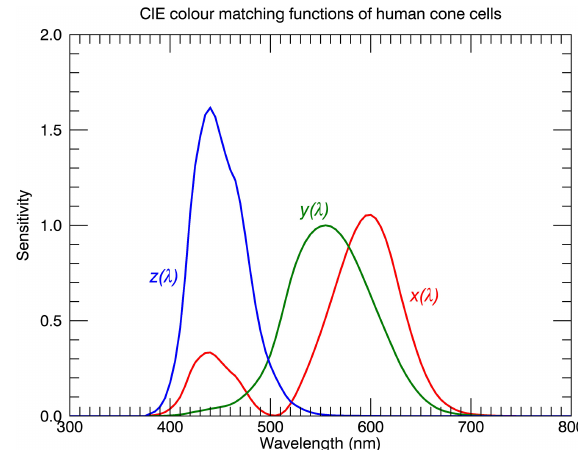
Figure 1. Illustration of the observation geometry, the relevant an- gles (i.e. solar zenith angle, SZA; viewing zenith angle, VZA; so- lar azimuth angle, SAA), the diffuse downward flux, and the near- horizon radiance. Note that the diffuse downward flux cannot be represented perfectly in a 2-D plot (please see text for more infor- mation).